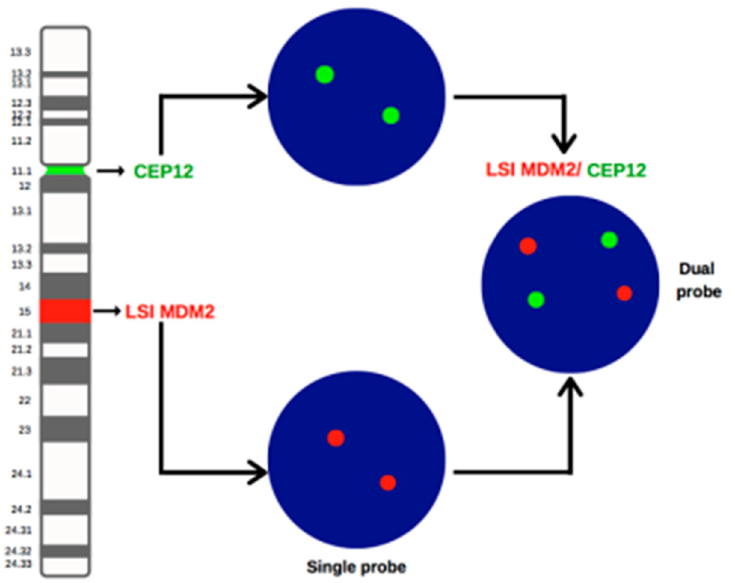
Figure 3. Schematic representation of the probes used for MDM2 gene evaluation and the expected FISH pattern. CEP12: centromeric probe for chromosome 12; LSI MDM2: Locus Specific Identifier for MDM2 gene; LSI MDM2/CEP12: dual probe.